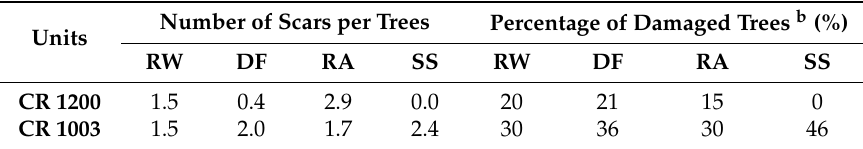
Table 4. Number and percent of scars per tree for each tree species a .